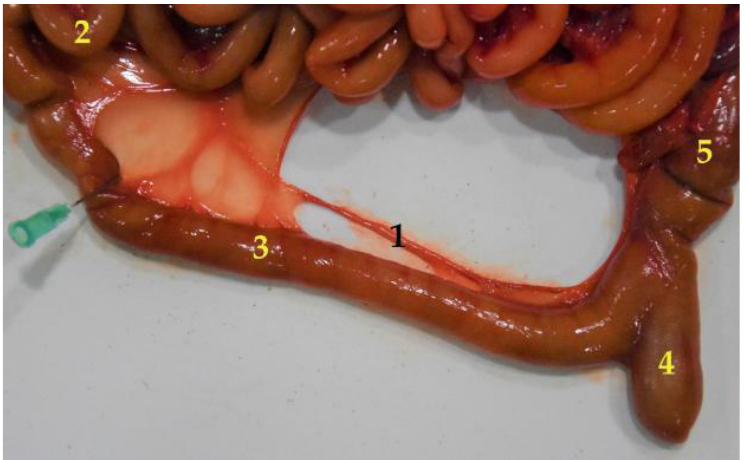
Figure 11. Differentiation of two segments of the small intestine (jejunum and ileum), pointed out by the last mesojejunal vessel, which splits off from the rest to reach the ileum. ( 1 ) Mesenteric vessel; ( 2 ) jejunum; ( 3 ) ileum; ( 4 ) cecum; ( 5 ) colon.